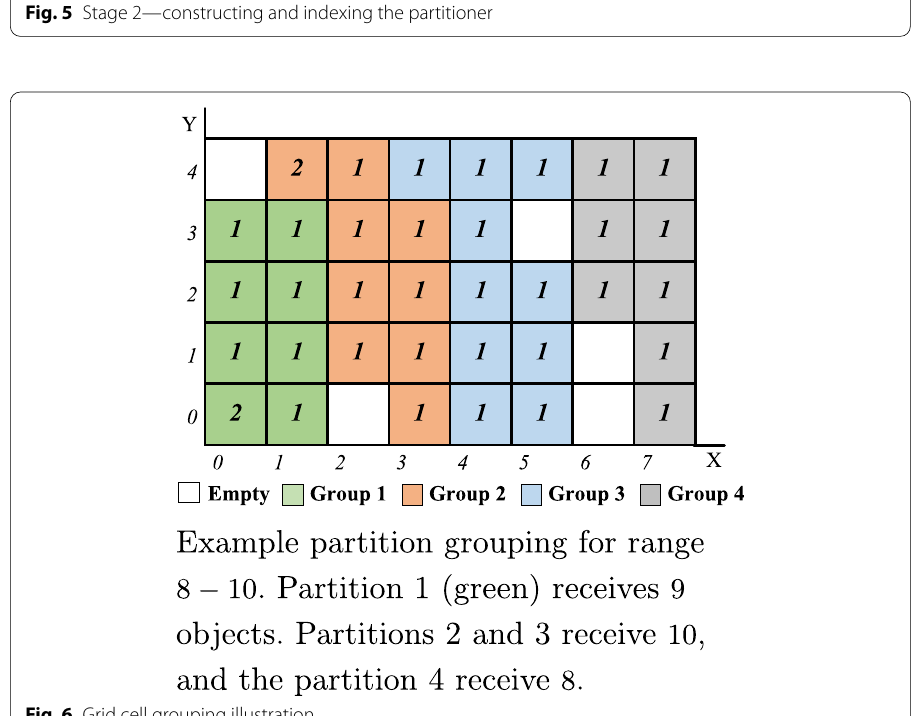
Fig. 6 Grid cell grouping